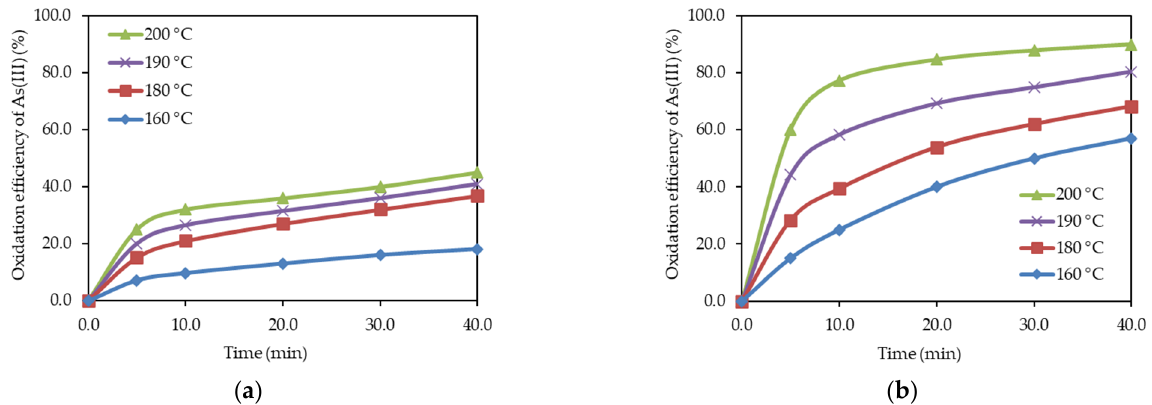
Figure 5. As (III) oxidation efficiency as a function of temperature with ( a ) and without ( b ) Cu (II) ions.